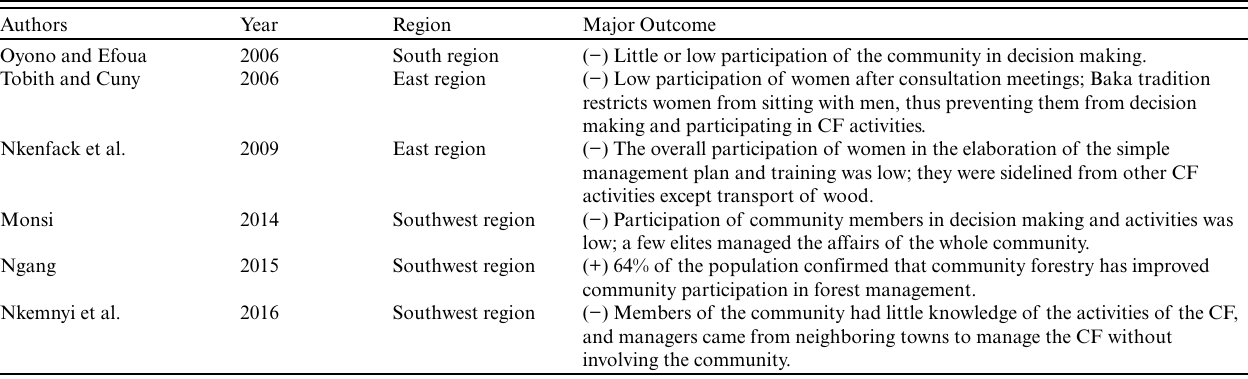
Table 3 . Participation and voice in community forests (CFs) in Cameroon. Authors Year Region Major Outcome (−) Little or low participation of the community in decision making. Tobith and Cuny East region (−) Low participation of women after consultation meetings; Baka tradition restricts women from sitting with men, thus preventing them from decision making and participating in CF activities. Nkenfack et al. East region (−) The overall participation of women in the elaboration of the simple management plan and training was low; they were sidelined from other CF Southwest